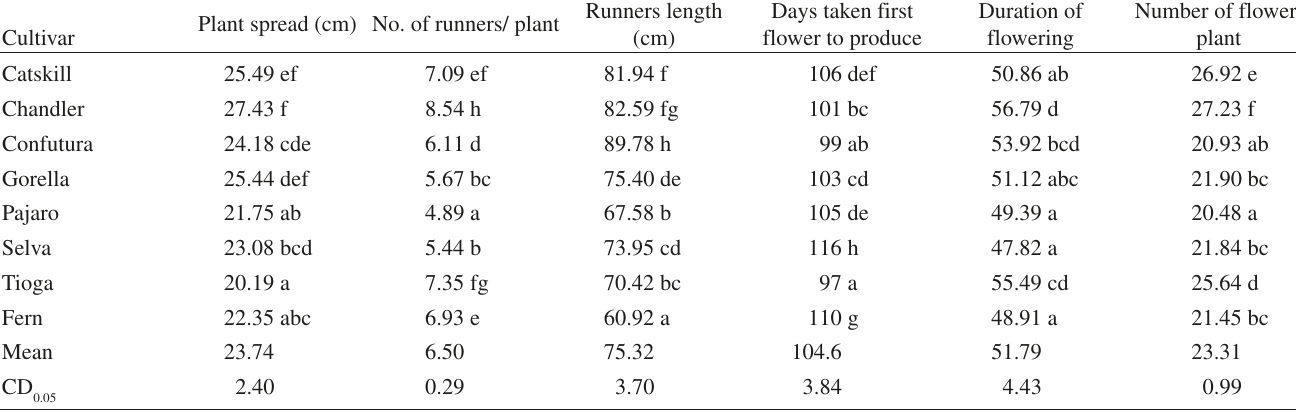
Runners length Days taken first Duration of (cm) flower to produce